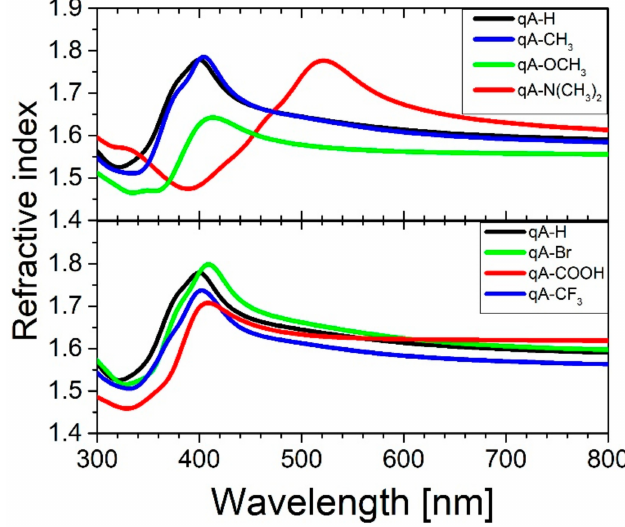
Figure 6. The refractive index ( n ) versus wavelength for the quinoline azo-dye polymers with various electron donating and electron withdrawing